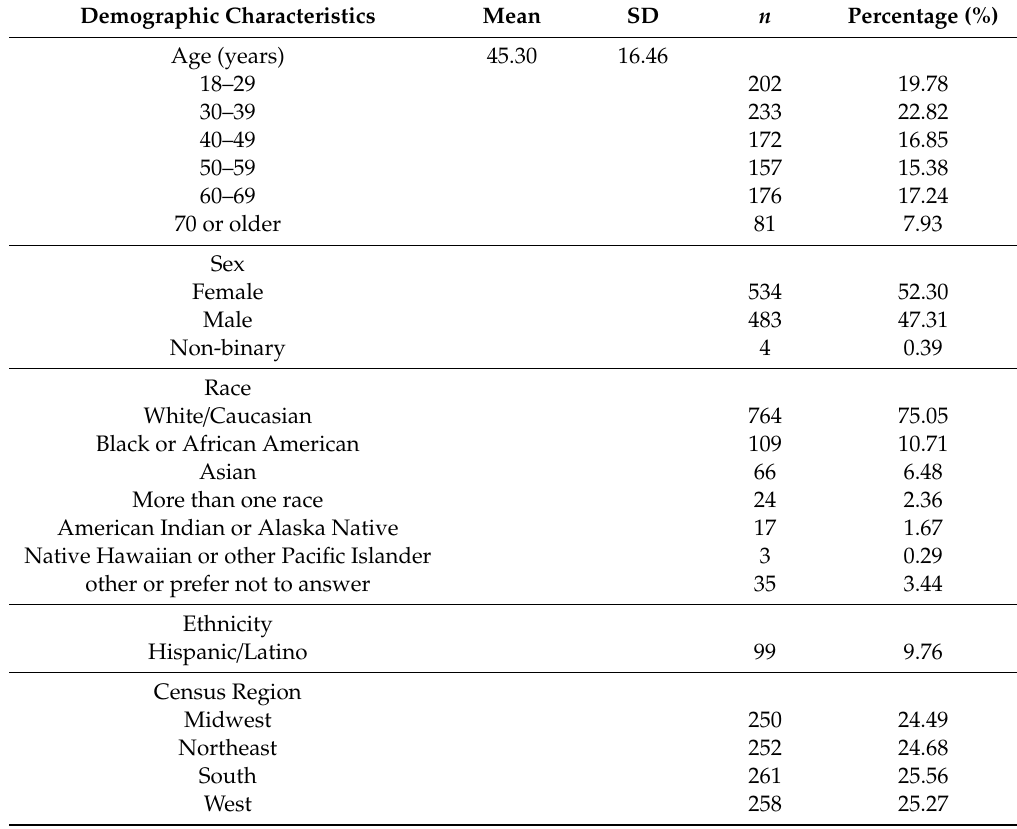
Table 1. Sample demographic statistics ( N wave1 =